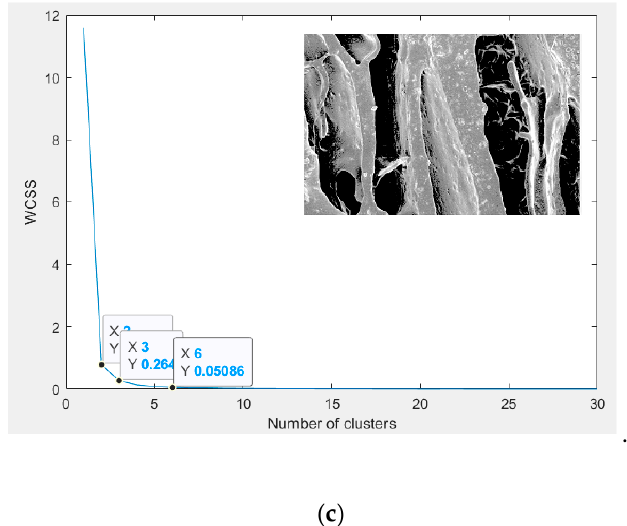
Figure 4. Highlighting the K optimal clusters number by elbow method; Chitosan 2 to 6 clusters ( a ), Chitosan/Silica Nanoparticle 2 to 5 clusters ( b ), Chitosan/Silica Nanoparticle/N 2 to 6 clusters ( c ).